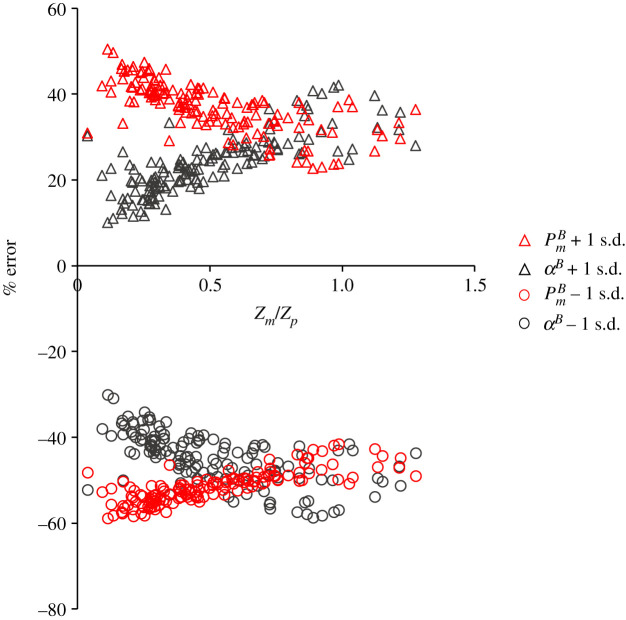
Results of a sensitivity analysis where the photosynthetic parameters PmB and αB were adjusted by ±1 s.d.. Per cent difference between model estimates of integrated production using mean and adjusted parameters are plotted against the depth of the subsurface chlorophyll peak divided by the depth of the euphotic zone (zm/zp). (Online version in colour.)